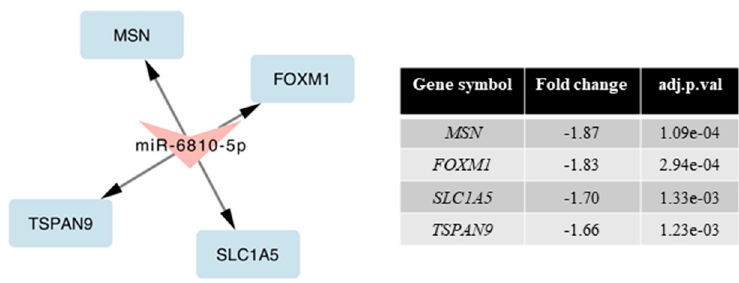
Figure 6. mRNA–miRNA interactions (BTZ-treated vs. control cells).